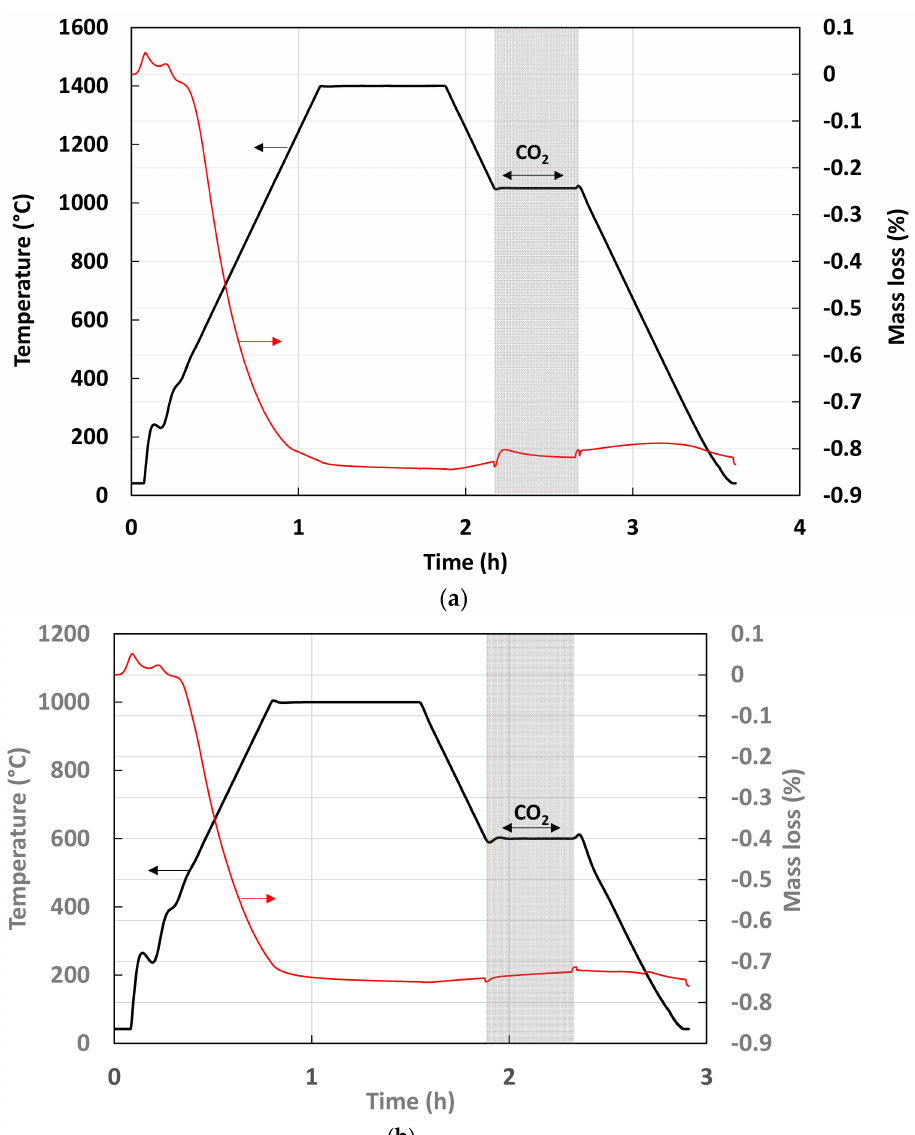
Figure 7. Thermogravimetric analysis of CO 2 -splitting cycles with HEO 3. ( a ) Reduction step at 1400 ◦ C and oxidation step at 1050 ◦ C; and ( b ) reduction step at 1000 ◦ C and oxidation step at 600 ◦